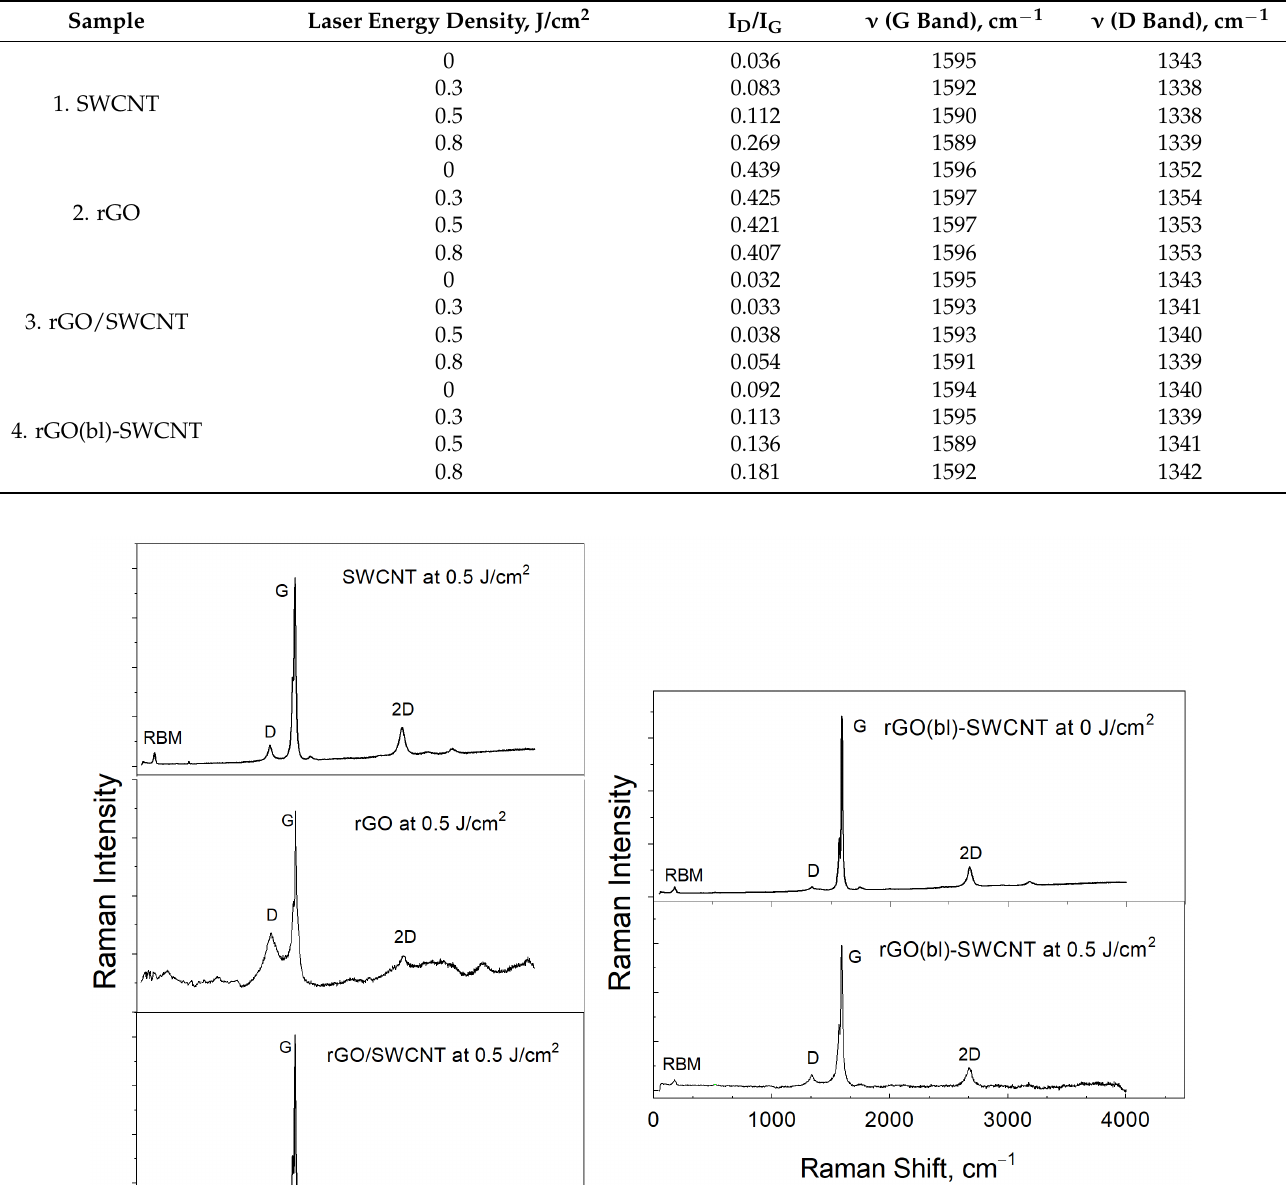
Table 2. Characterization of Raman spectra via characteristic bands for SWCNT, rGO, rGO/SWCNT, and rGO(bl)-SWCNT nanostructures.